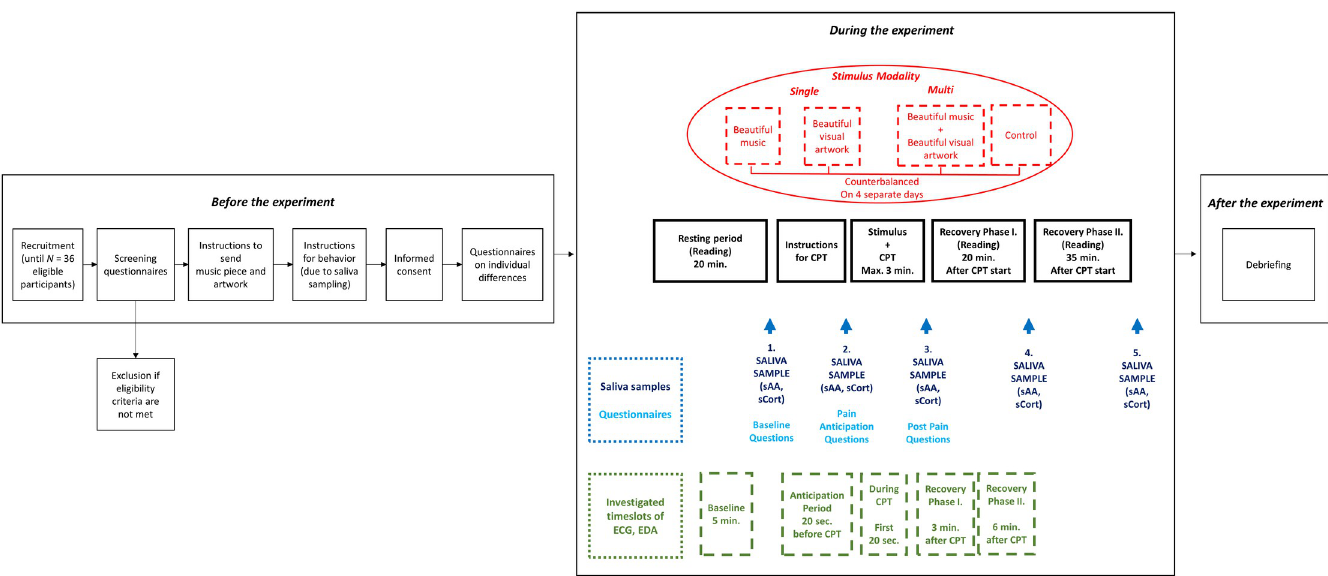
Fig 2. Procedure of the study (before, during, after the experiment). CPT = cold pressor test; ECG = electrocardiogram; EDA = electrodermal activity; sAA = salivary alpha-amylase; sCort = salivary